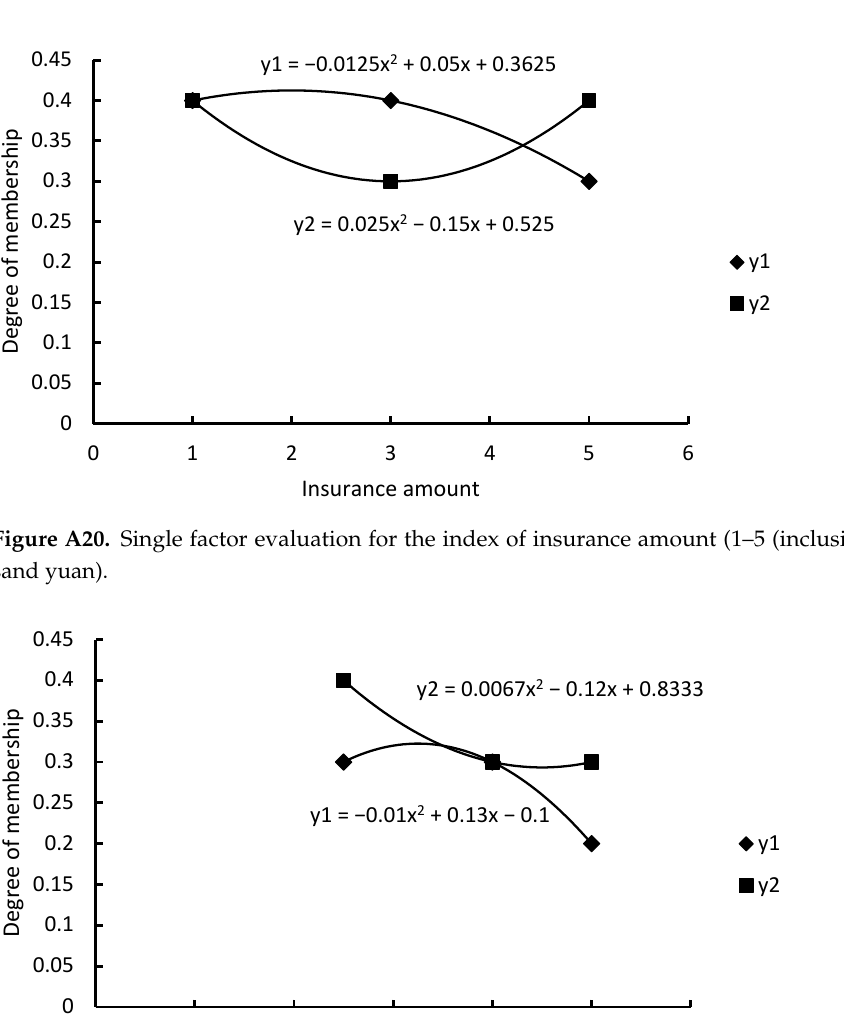
Figure A19. Single factor evaluation for the index of insurance amount (0.5–1 (inclusive) ten thou- sand yuan).